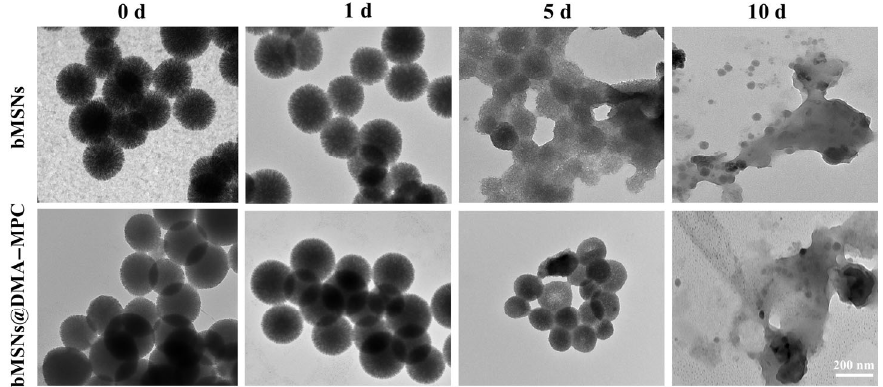
Fig. 8 Representative TEM images for the characterization of biodegradation properties of the bMSNs and bMSNs@DMA–MPC (1:4) nanoparticles incubated in SBF at 37 °C.